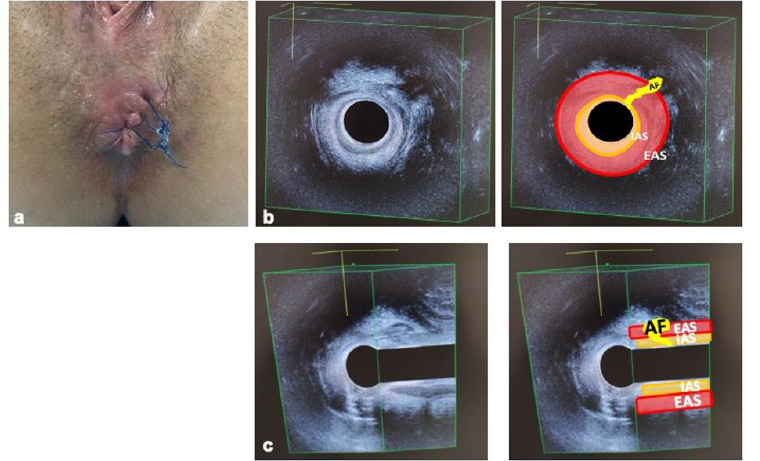
Figure 1. Preoperative aspect ( a ), and 3D-EAUS imaging (( b ), axial view; ( c ), longitudinal view) of the transphinteric anal fistula to be submitted to the human amniotic membrane implantation. Fistula resulted from an anal abscess previously drained with seton placement. AF: anal fistula; IAS: internal anal sphincter; EAS: external anal